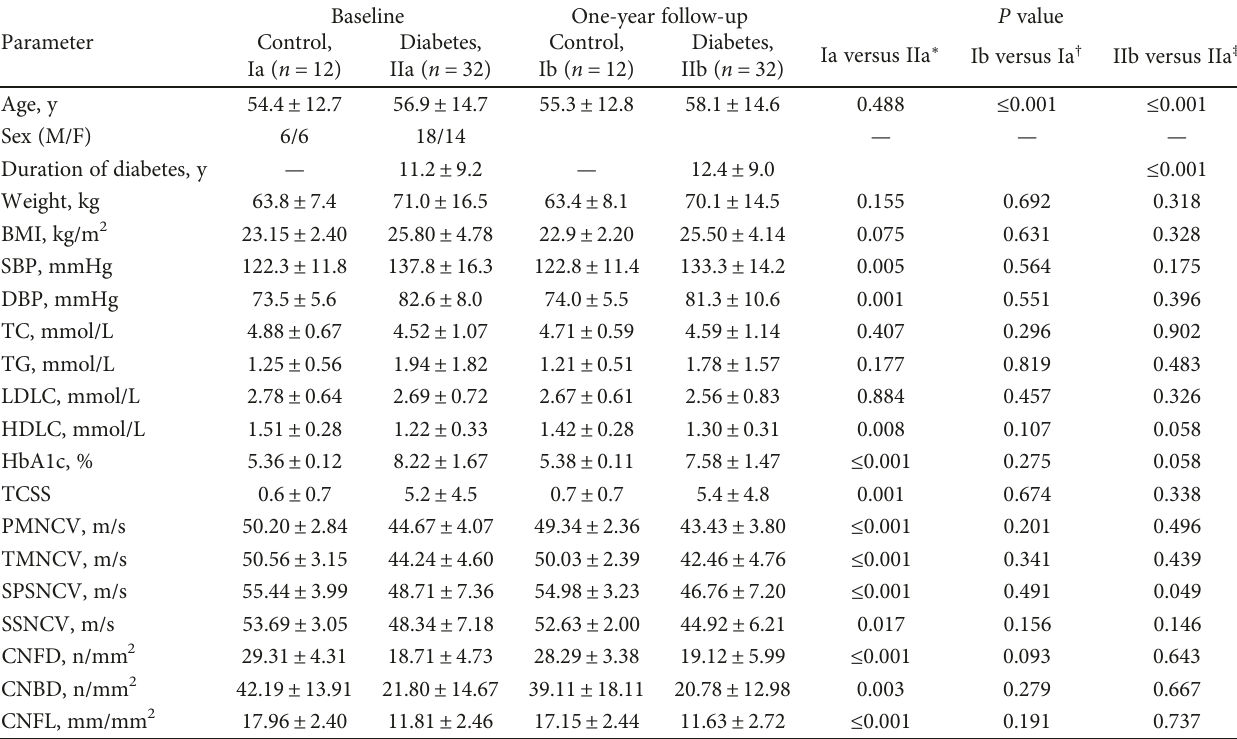
Table 1: Clinical characteristics of control subjects and patients with diabetes at baseline and one-year follow-up. Parameter